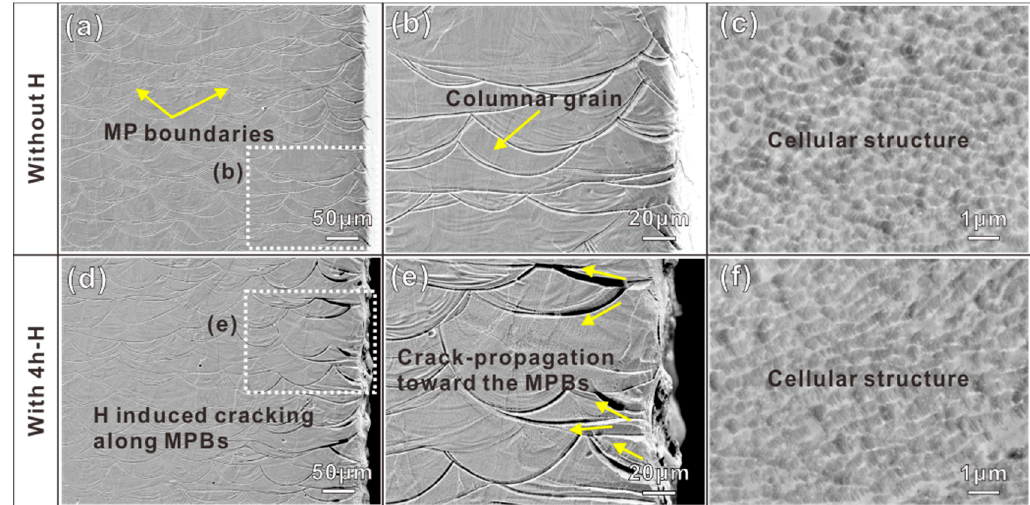
Figure 3. SEM maps of the surface of samples without ( a – c ) and with H ‐ charged ( d – f ).